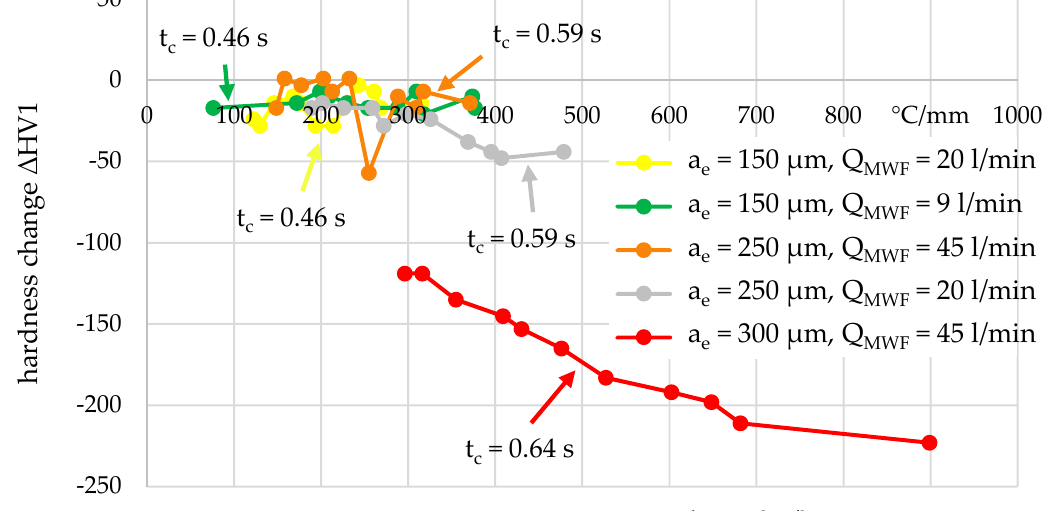
Figure 9. Hardness change dependent on the maximum temperature gradient for different process parameter combinations